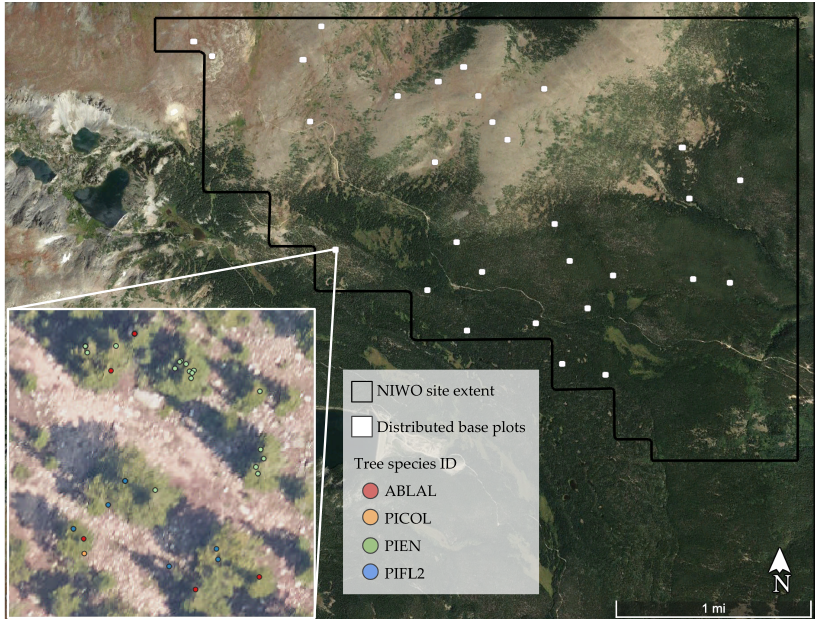
Figure 2. Map showing the extent of the NEON NIWO site and distributed sampling plots. Inset zoomed view shows an example of individual tree locations along with their associated species for a single sampling